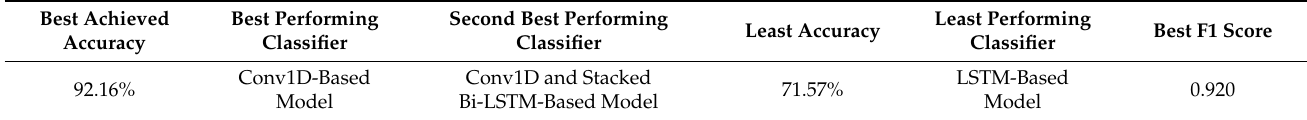
Table 6. Comparison among the experimental